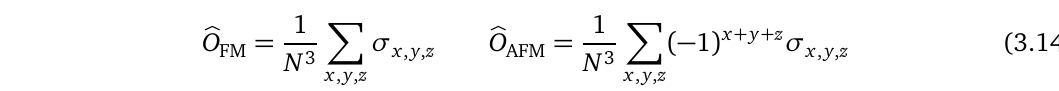
Table 1: Order parameters (columns) which are nonzero in various vacuum config- urations (rows), together with symmetries preserved by each phase. Note that the Plumber’s nightmare II and the packed phase break the same symmetries and thus belong to the same phase. Phase FM AFM O + O − Unbroken subgroup H ⊂ G Paramagnetic 0 0 0 0 All FM × 0 0 0 Lattice symmetries S AFM 0 × 0 0 Lattice symmetries S Plumber’s nightmare I 0 × 0 × T Plumber’s nightmare II 0 0 × × None Packed × × × × None Dilute × 0 × 0 T